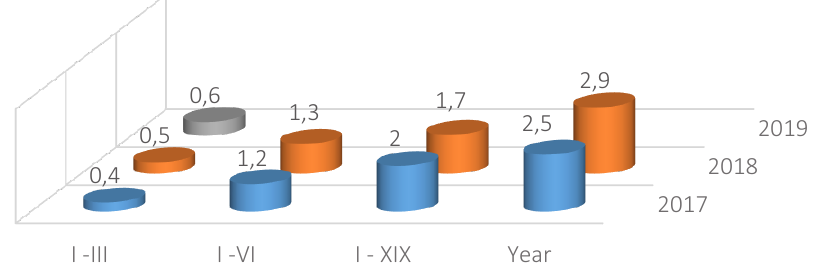
Figure 7. Acquisition of direct investment in Ukraine (USD